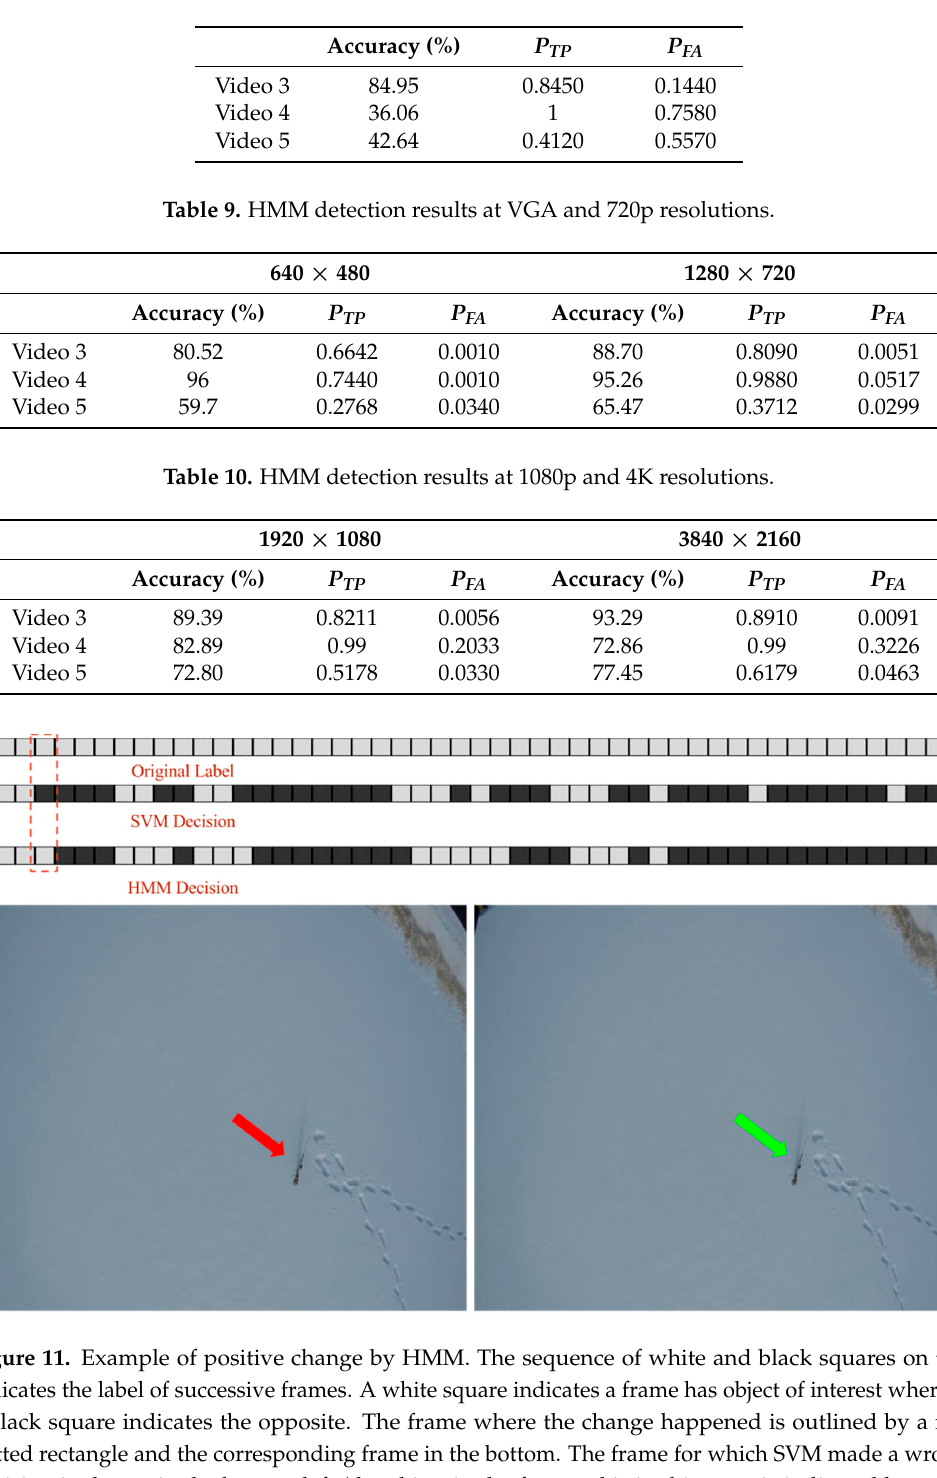
Figure 12. Example of negative change by HMM. The sequence of white and black squares on top indicates the label of successive frames. White squares indicate a frame has an object of interest, whereas black squares indicate the opposite. The frame where the change happened is outlined by a red dotted rectangle. The frame for which SVM made the right decision, with the object localized in a green rectangle, is shown in the bottom left. The same frame, for which HMM made a wrong decision, is shown in the bottom right.